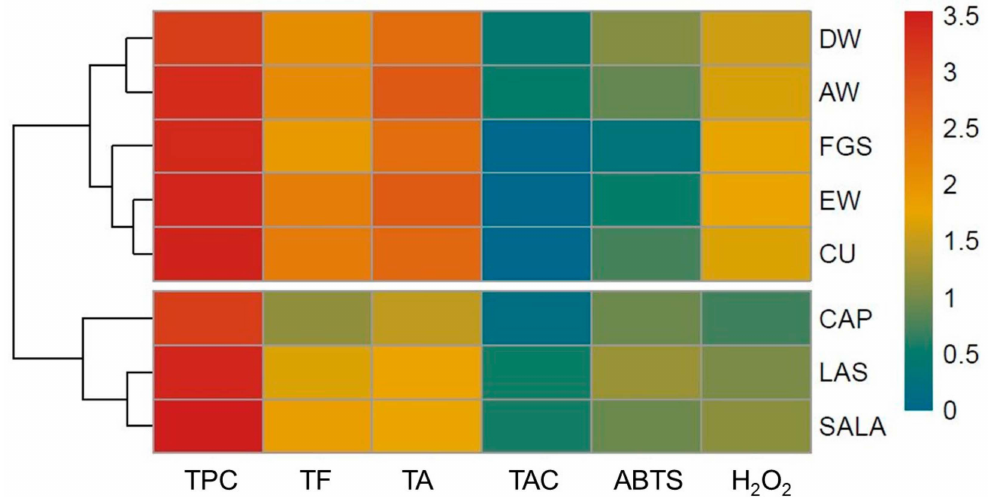
Figure 6. Heatmap and dendrogram of the total phenolic content (TPC), total flavonoid (TF), total alkaloids (TA), total anthocyanin (TAC), and antioxidant activity (ABTS, and H 2 O 2 scavenging activ- ity) of extracts from tobacco inflorescence waste obtained with conventional and non-conventional solvents. DW: distilled water; EW: ethanol 70 ◦ ; AW: acetone:water; NaDESs: LAS, CAP, FGS, SALA,